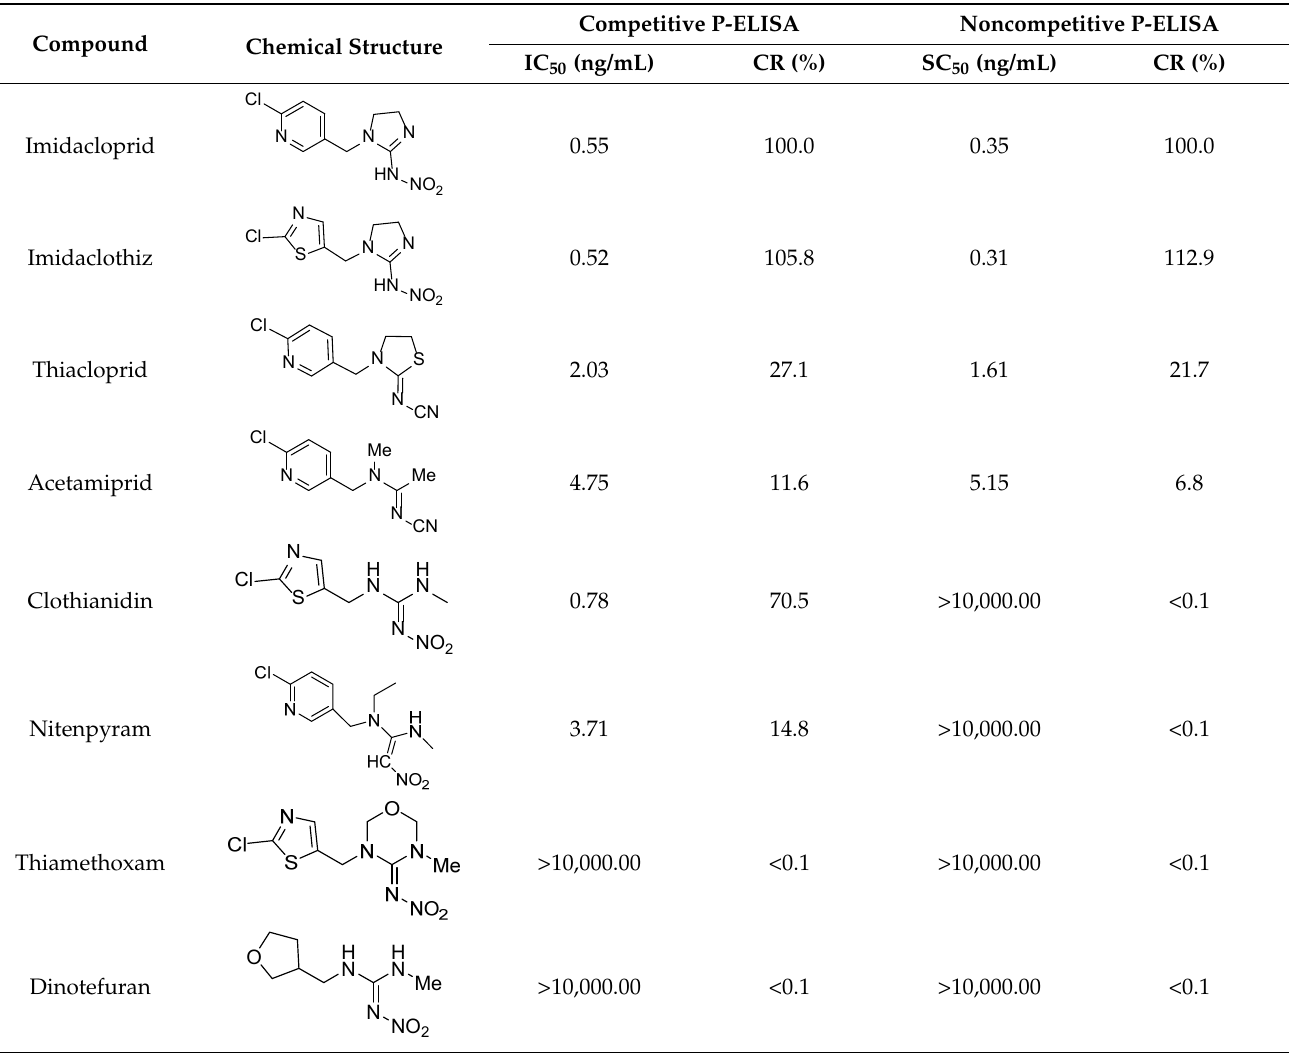
Table 2. CR of P-ELISAs with other neonicotinoids ( n = 3).